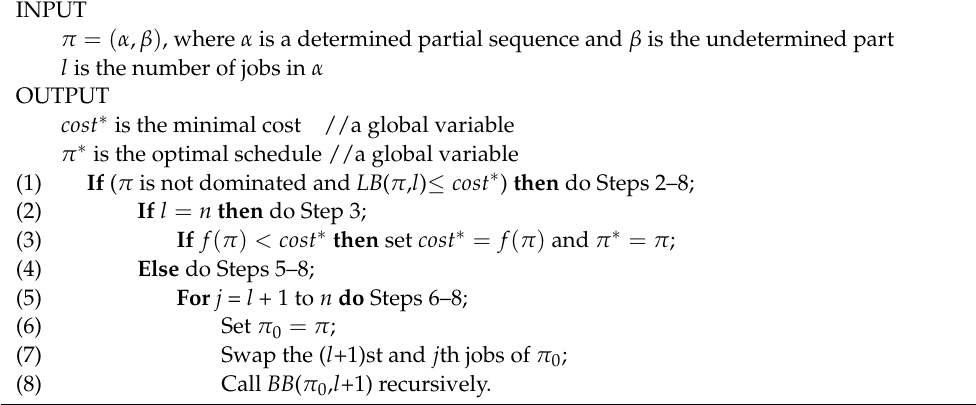
Algorithm 2. The proposed branch-and-bound algorithm ( BB ( π , l